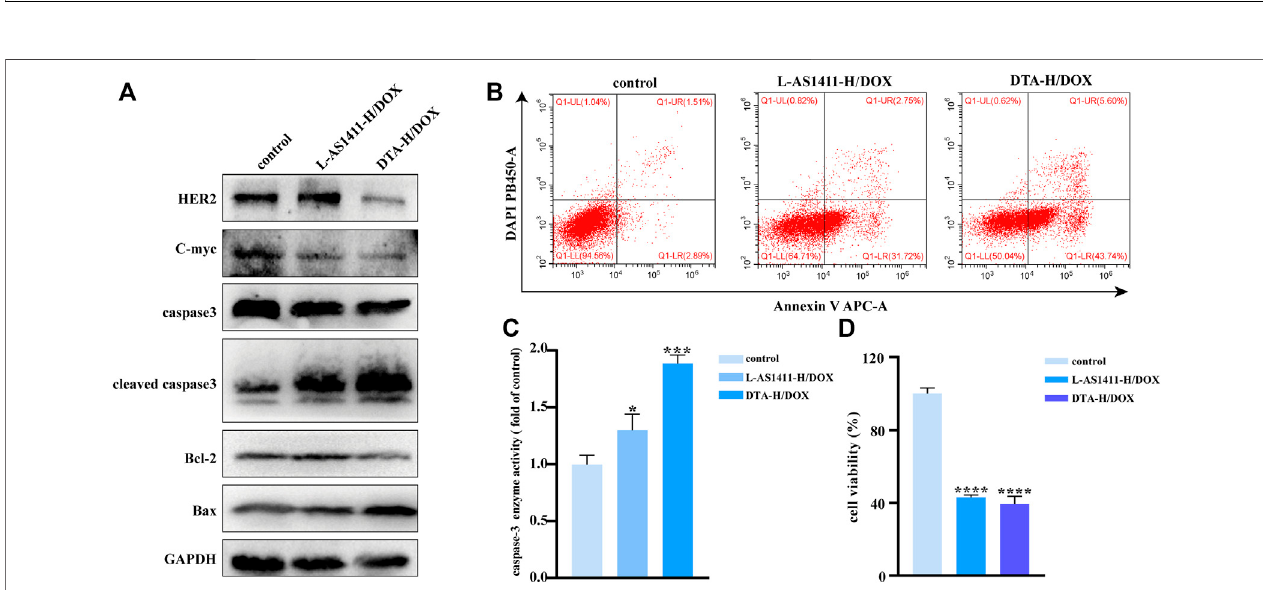
FIGURE 4 | Therapeutic effect in vitro of DNA hydrogel loaded with DOX. (A) Western blotting of HER2, apoptosis, and proliferation-related protein expression changes of SK-BR-3 cells incubated with L-AS1411-H/DOX or DTA-H/DOX for 24 h. (B) Flow cytometry of cell apoptosis of SK-BR-3 cells exposed to L-AS1411-H/ DOX or DTA-H/DOX for 24 h. (C) Changes in caspase-3 activity and (D) cell viability assay (CCK-8 assay) of SK-BR-3 after treatment with L-AS1411-H/DOX or DTA-H/ DOXfor24 h. Errorbarsdenotestandarddeviationsfrom threeindependent experiments. Statisticalanalysis:* p < 0.05vs.control;*** p < 0.001vs.control; **** p < 0.0001 vs.